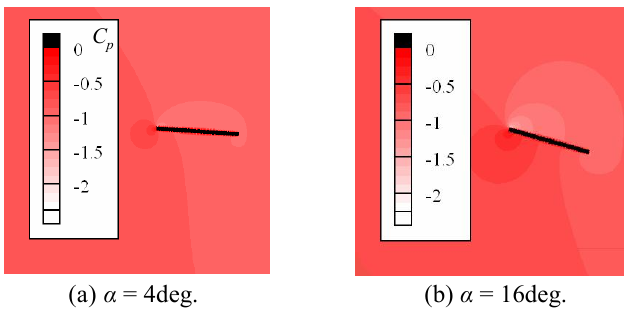
Fig. 9 Pressure distribution at Re = 1.0×10 2 (flat plate, α = 4 and 16